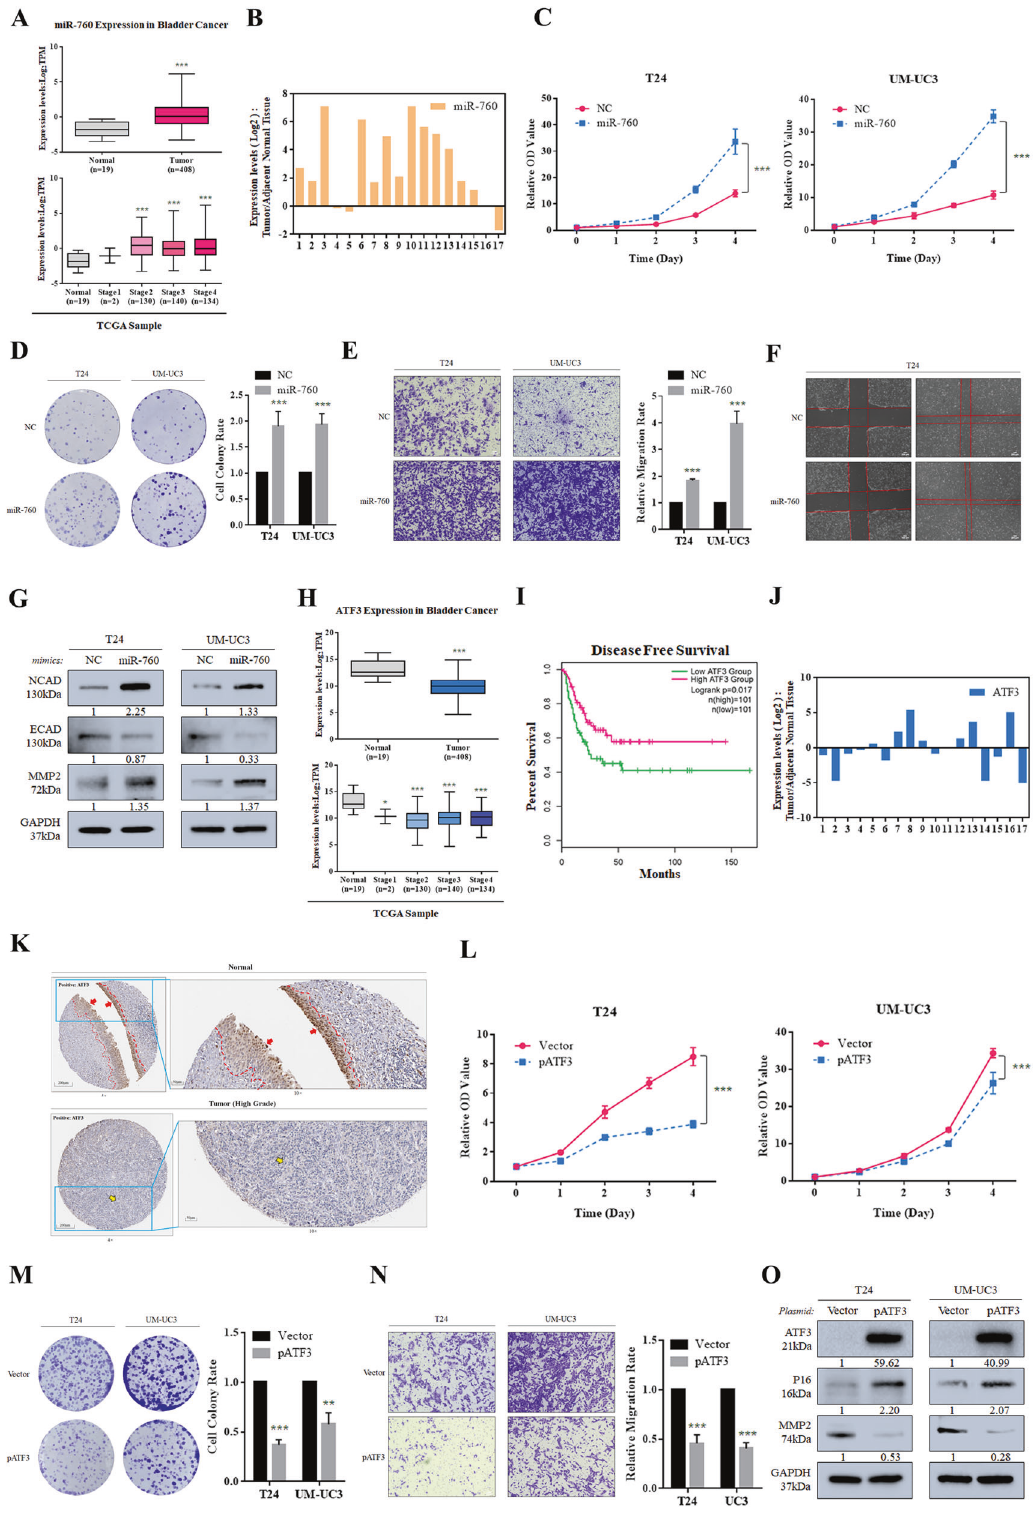
pmirGLO Dual-Luciferase miRNA Target Expression Vector (Promega), between SacI and SalI sites followed by DNA sequencing con fi rmation. Cells were seeded in 96-well plates and co-transfected with miR-760 or siMETTL1 and reporter pmirGLO. Dual-Luciferase Reporter Assay System (Promega) was used to evaluate the relative luciferase activity at 48 h after transfection.